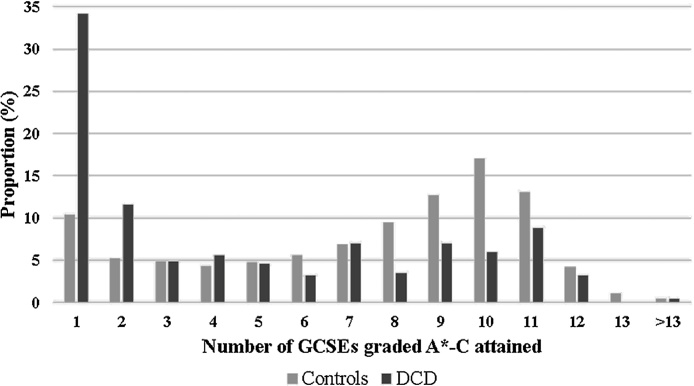
Number of GCSEs graded A*-C achieved by controls and those with developmental coordination disorder (DCD).